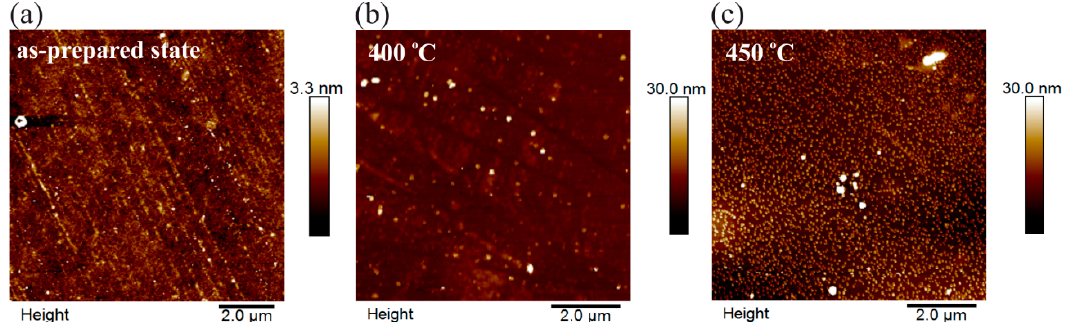
Figure 5. Atomic force microscopy (AFM) patterns of the Fe 73.5 Nb 3 Cu 1 Si 13.5 B 9 films with thickness of 200 nm in the as-prepared state ( a ) and after the annealing ( b , c ).